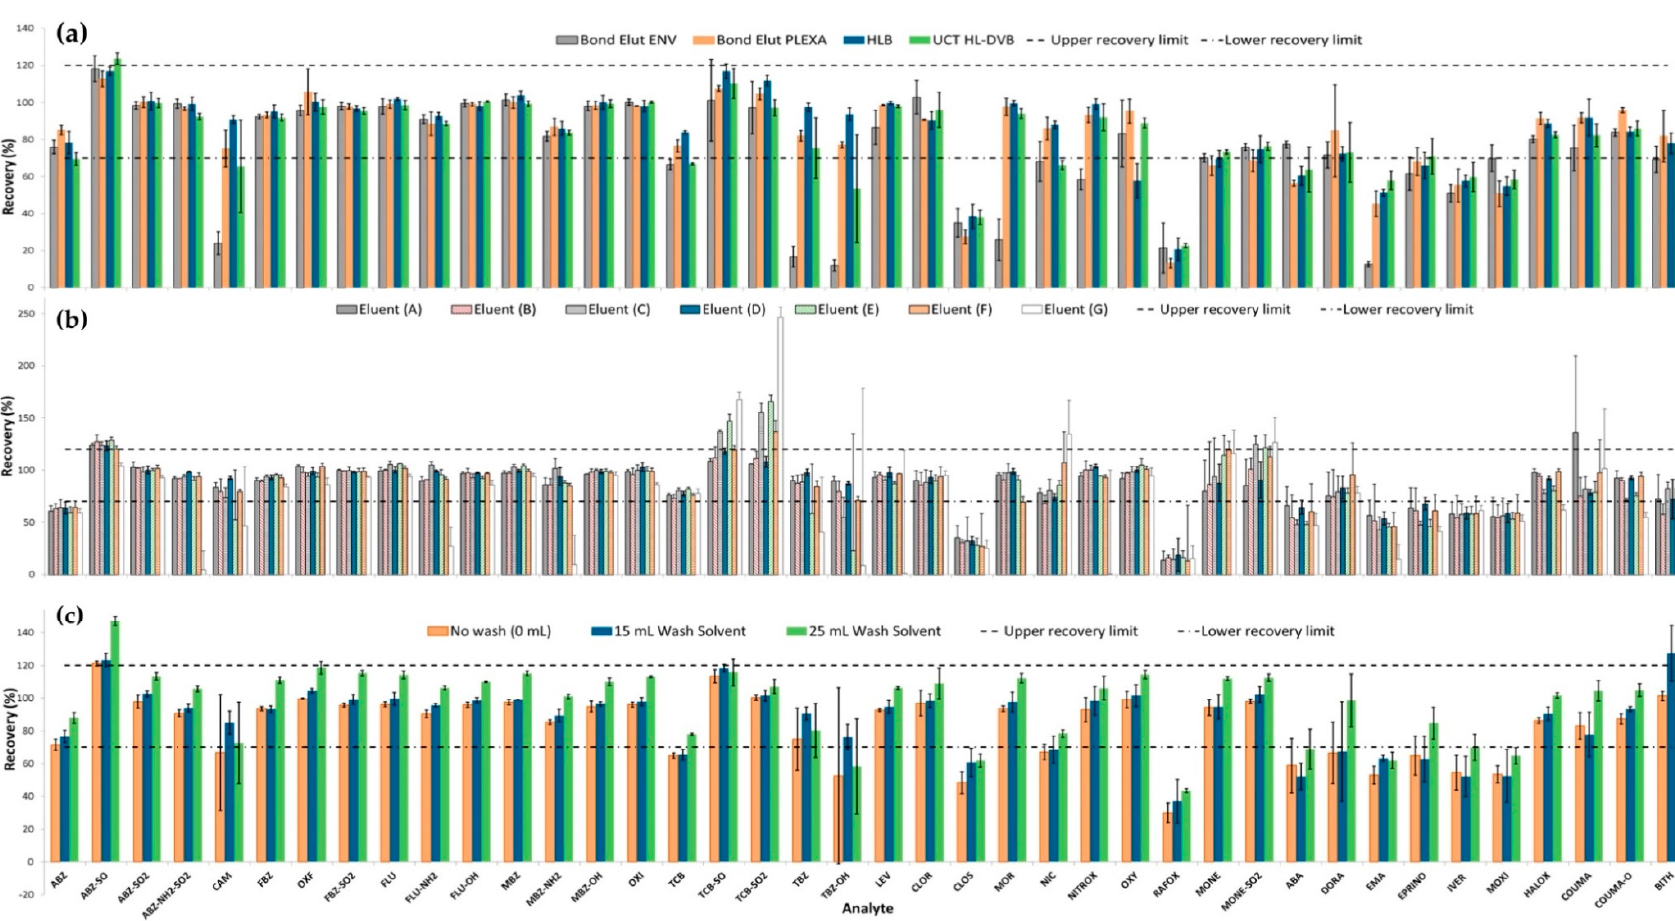
Figure 1. Mean recoveries (%) and precision (%RSD, shown by error bars)( n = 3) for assessment of: (a) four different SPE Cartridges (Bond Elut ENV, Bond Elut Plexa, Oasis HLB and UCT HL-DVB) eluted with 50: 50 MeOH: MeCN (v/v) (10 mL) (b) seven different eluent compositions: (A) = 50/50 MeOH/MeCN (10 mL), (B) = 50/50 MeOH/MeCN (5 mL) + Acetone (5 mL), (C) = 50/50 MeOH/MeCN (5 mL) + MTBE (5 mL) (D) = 50/50 MeOH/Acetone (10 mL), (E) = 50/50 MeCN/MTBE (10 mL), (F) = 100% Acetone (10 mL) and (G) = 100% MTBE (10 mL) using the HL-DVB cartridge (200 mg, 6 mL) and (c) three different volumes (0, 15 and 25 mL) of water: methanol (90:10, v/v) wash solution using the same HL-DVB cartridge.